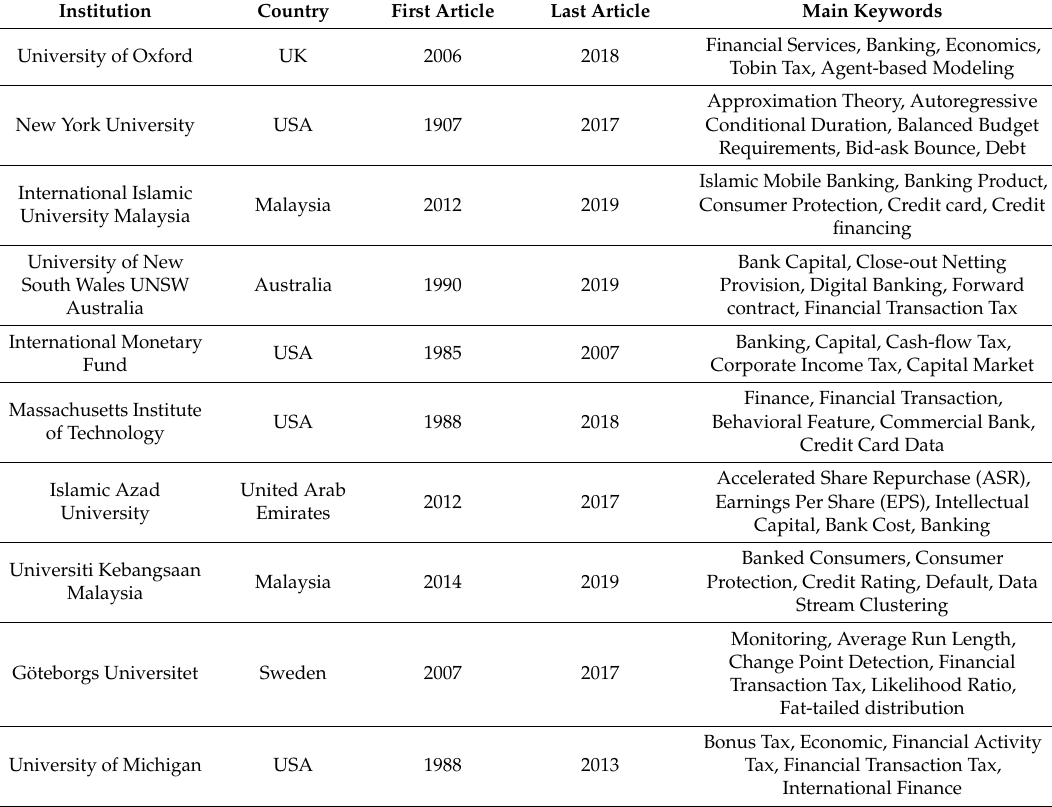
Table 5. Main institutions and keywords